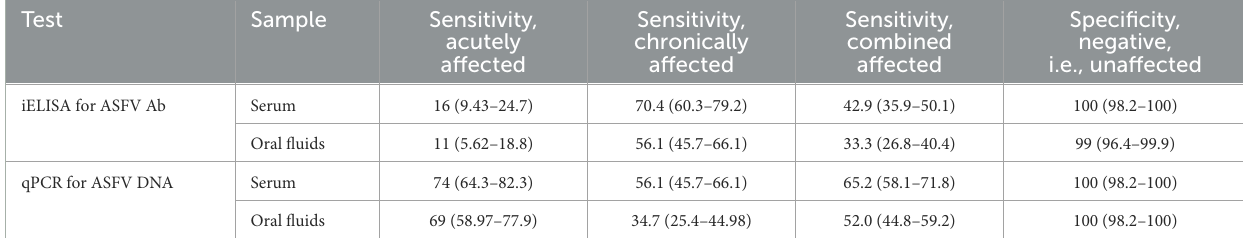
TABLE 4 Estimates of diagnostic sensitivity (DSe) of ASFV iELISA and qPCR ASFV DNA assay for serum and oral fluid samples in acute, chronic, and combined-ASF-affected populations assuming true disease status, and diagnostic specificity (DSp) estimates in free-population, with 95% Clopper-Pearson confidence